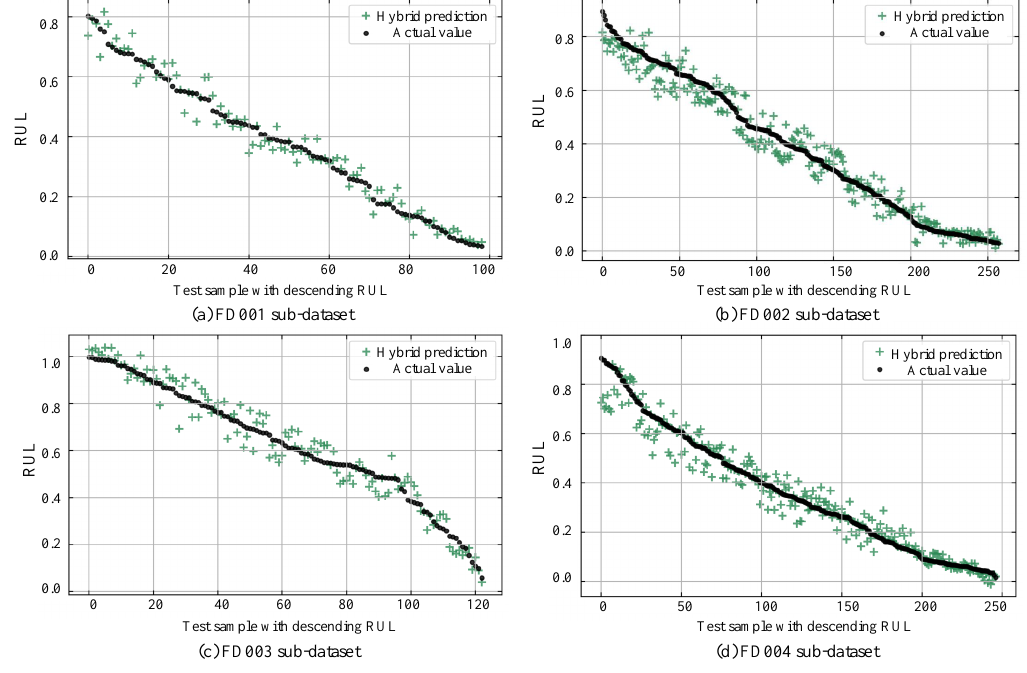
Figure 11. The prediction results of the hybrid model for four sorted sub-datasets (FD001, FD002, FD003, FD004) are shown in ( a – d )